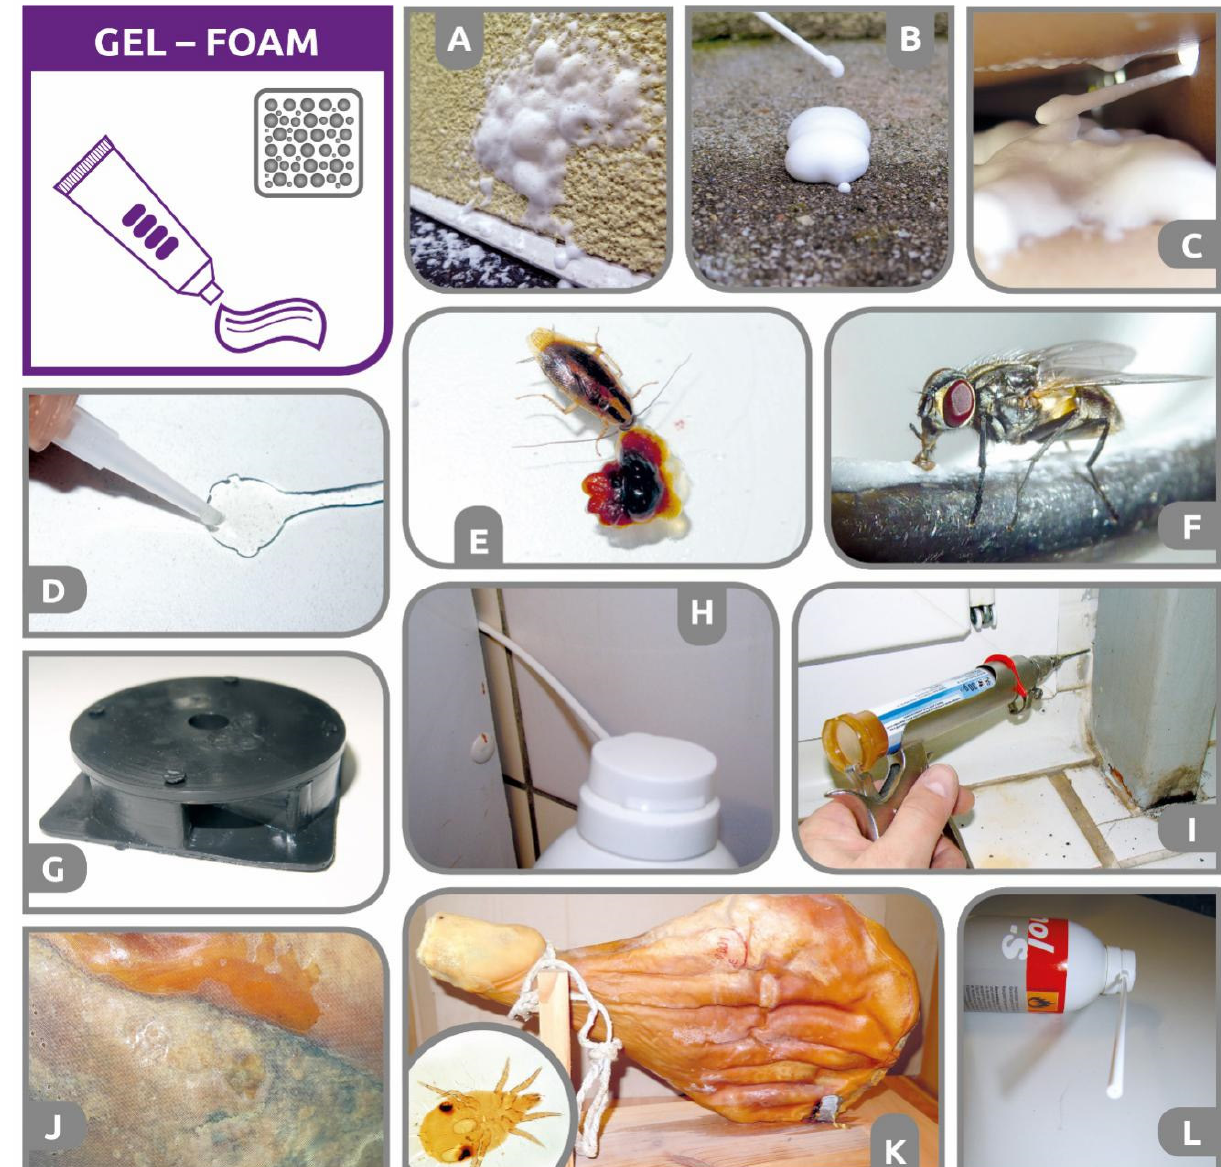
Figure 4. Gels and foams. ( A , B ) Insecticide foams can be applied on vertical and horizontal surfaces; ( C ) foam injected into cracks and crevices and voids; ( D – F ) gel and/or foam bait for ants, cockroaches, and flies, respectively; ( G ) bait administered in a plastic resistant box; ( H ) foams and gels that can be applied from ready-to-use pressurized containers; ( I ) gel bait application into cracks and crevices using injection guns; ( J ) detail of protective gels applied on ham directly or on ham nets; ( K ) ham surface gel protection against mites; ( L ) detail of a plastic tube gel or foam injector (photographs A–L: V. Stejskal; R. Aulicky, T. Vendl).